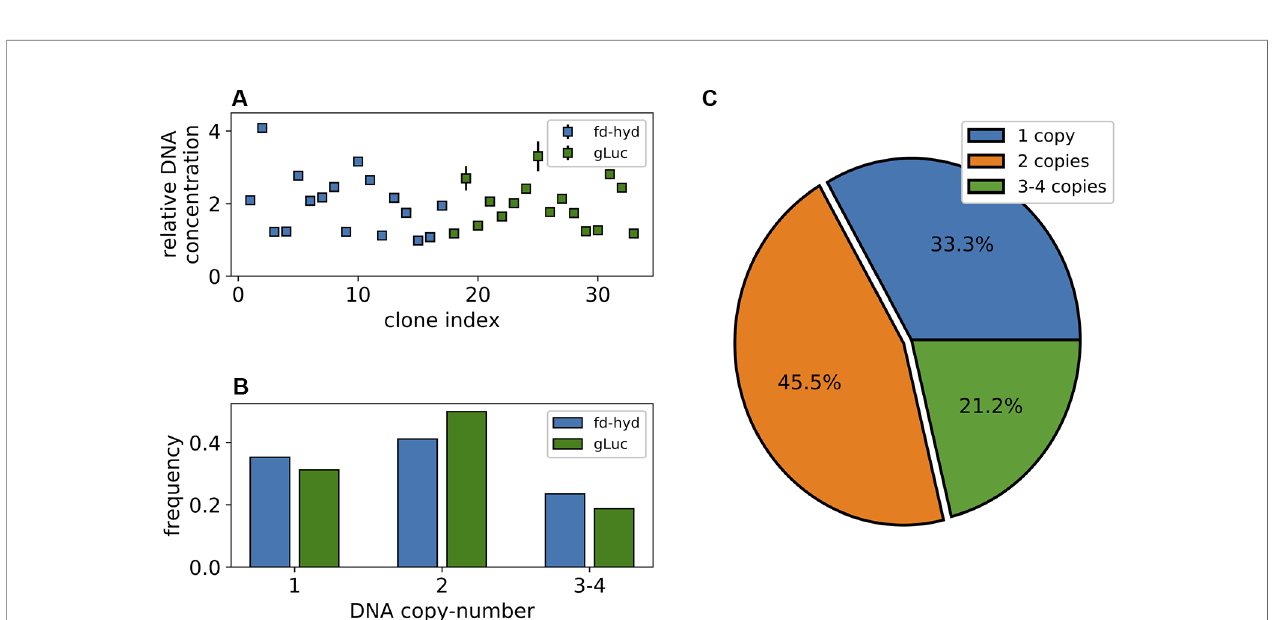
FIGURE 2 | Synthetic copy-number variation of the fd-hyd and the gLuc transgenic clones. (A) Transgenes DNA copy-number in 33 nucleus-transformed clones. Copy-number values are calculated as the ratio of the target's concentration to the reference gene ( CBLP ) concentration. The error bars represent the maximum and minimum values of Poisson distribution for the 95% con fi dence interval, as given by the QuantaSoft ™ software. (B) The ratio of clones found in each copy-number group separated by the reporter gene. (C) Distribution of transgenes' copy-number in all clones.